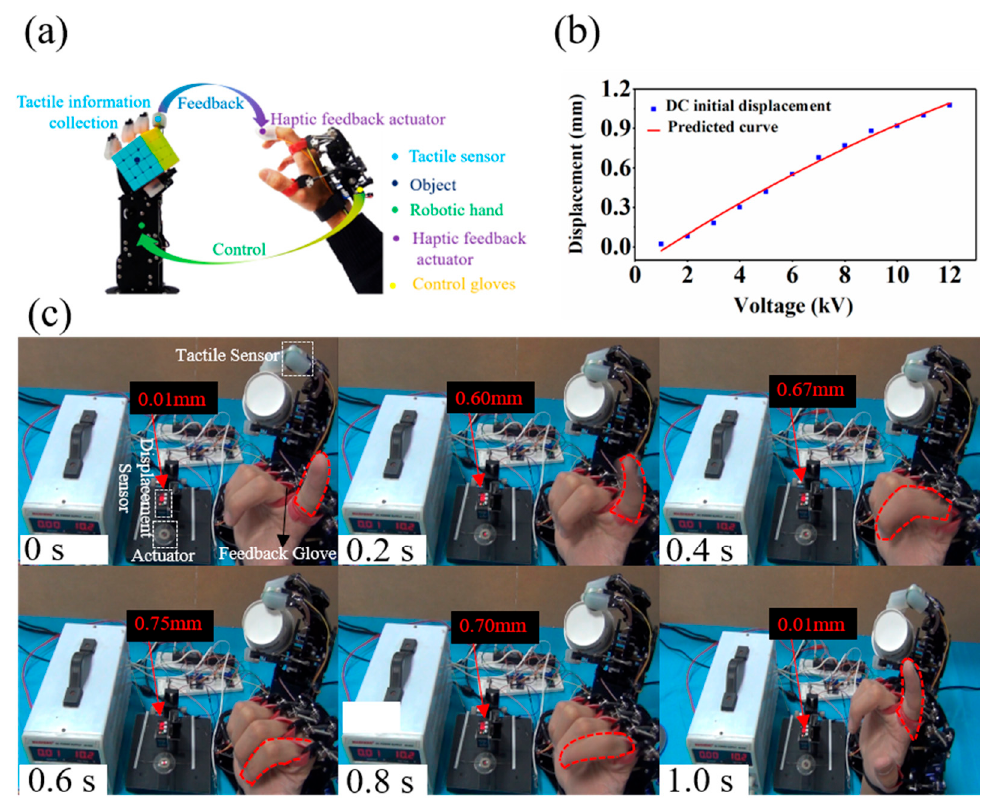
Figure 10. ( a ) Schematic diagram of the haptic feedback teleoperation system. ( b ) Displacement of the actuator as a function of electric field. ( c ) The operation process of the haptic feedback teleoperation system.